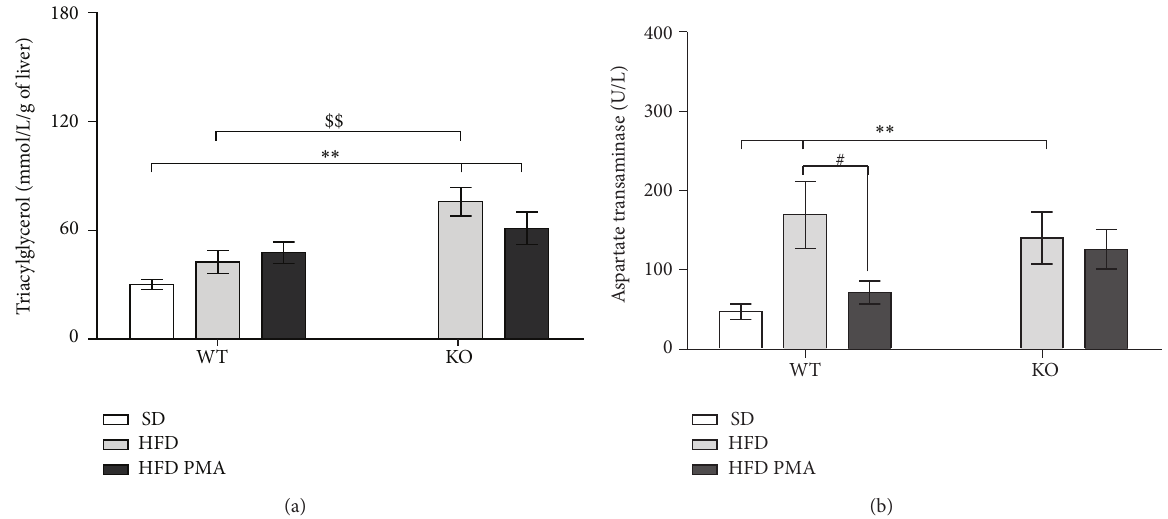
Figure 2: Triacylglycerol levels in the livers (a) and aspartate aminotransferase levels in the plasma (b) of WT mice fed with a standard diet (SD) or WT and PPAR 𝛼 -knockout (KO) subjected to a high-fat diet and treated with oleic acid (HFD) or palmitoleic acid (HFD PMA). The data are presented as mean ± SEM. ∗ 𝑃 < 0.05 and ∗∗ 𝑃 < 0.01 versus WT SD; # 𝑃 < 0.05 HFD versus HFD PMA; and $$ 𝑃 < 0.01 KO versus the respective WT control (one-way ANOVA followed by Bonferroni correction).